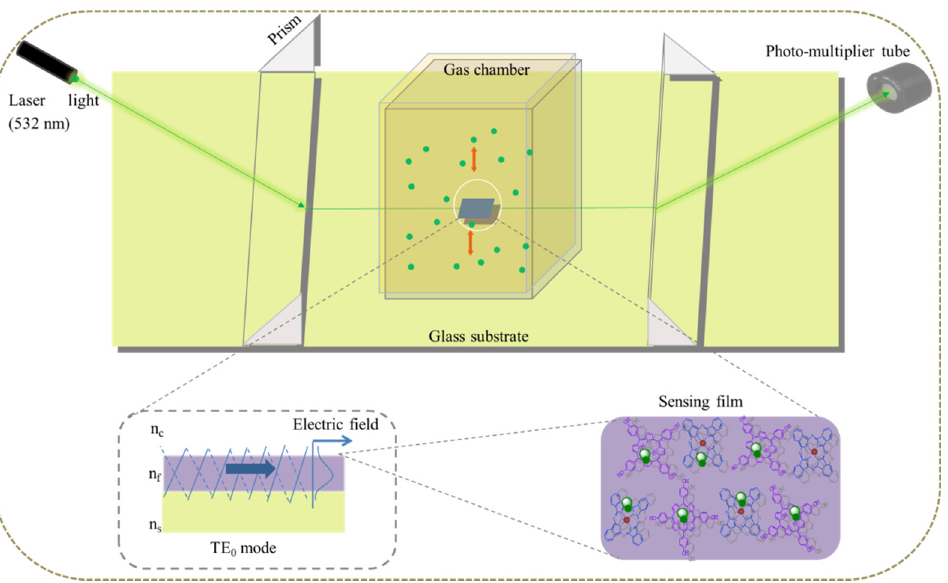
Figure 2. Schematic diagram of the homemade planar optical waveguide (POWG) detection system. Sensitivity in analyte concentration detection is due to evanescent wave, which is part of the guiding light coming out the sensing film surface into the surrounding air. A guiding wave in TE 0 mode (transverse electric mode) [27] is formed in the sensing film by differentiating the refractive index. This is obtained applying a potassium-ion-exchanged glass substrate with a layer (1–2 μ m) of higher refractive index (n = 1.52) with respect to the whole body of the substrate (n = 1.51), and by adjusting manually the propagation angle to 70° in POWG platform [28].